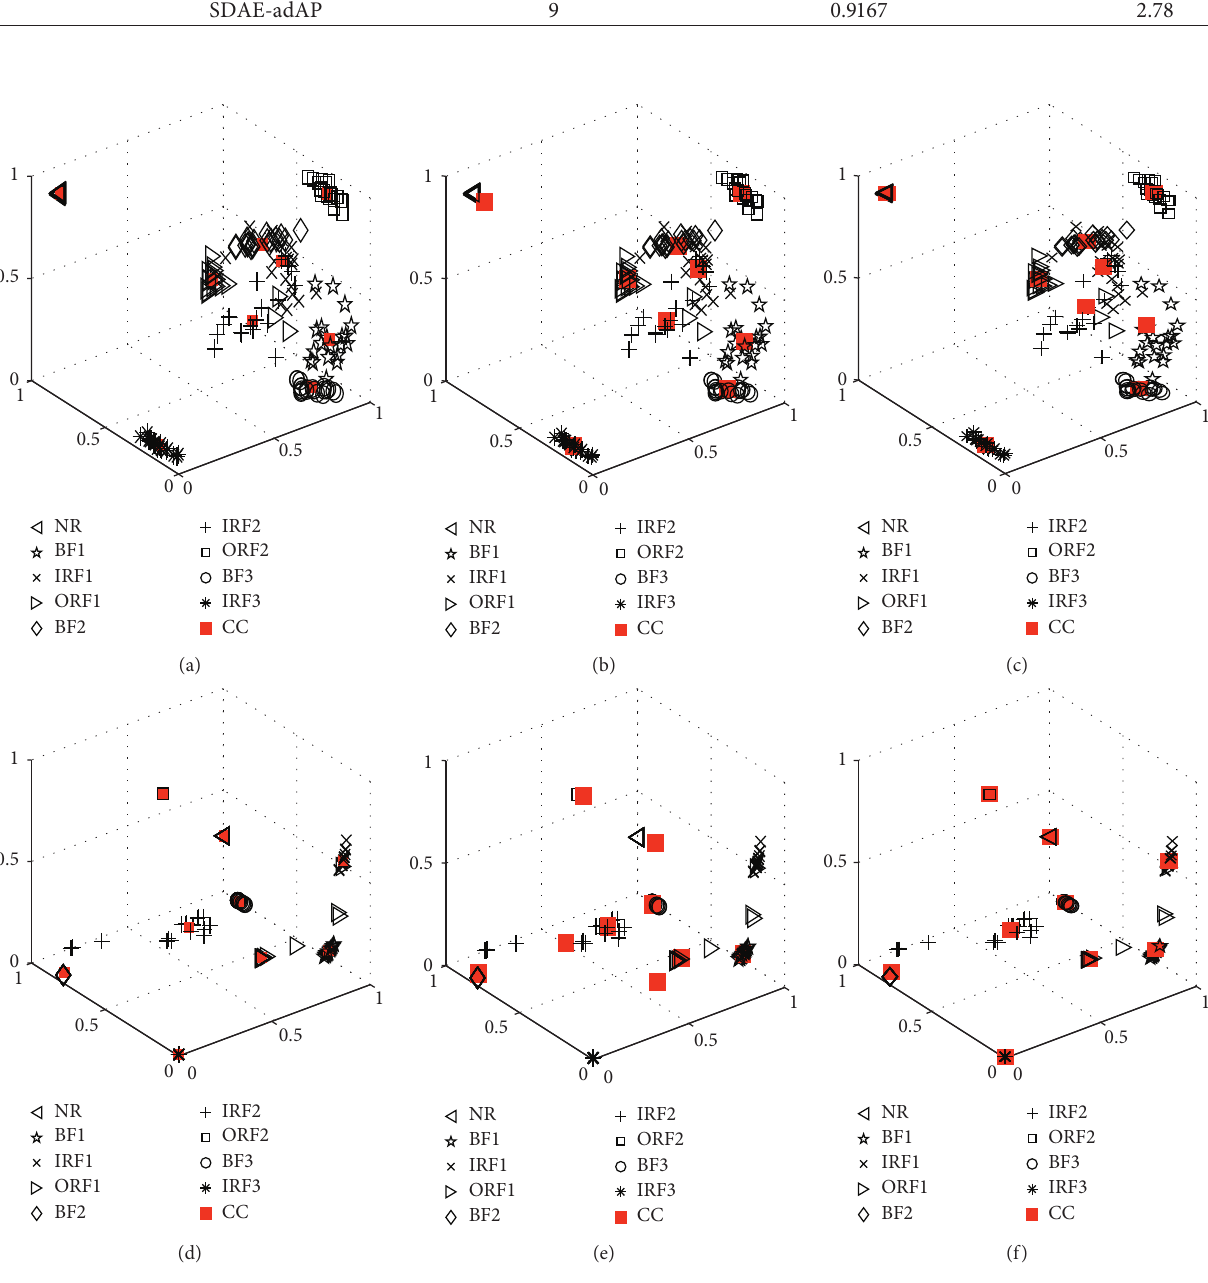
Figure 16: The 3-dimensional clustering results for the testing dataset A by using an SAE/SDAE with FCM/GK/GG. (a) SAE-FCM-A. (b) SAE-GK-A. (c) SAE-GG-A. (d) SDAE-FCM-A. (e) SDAE-GK-A. (f)